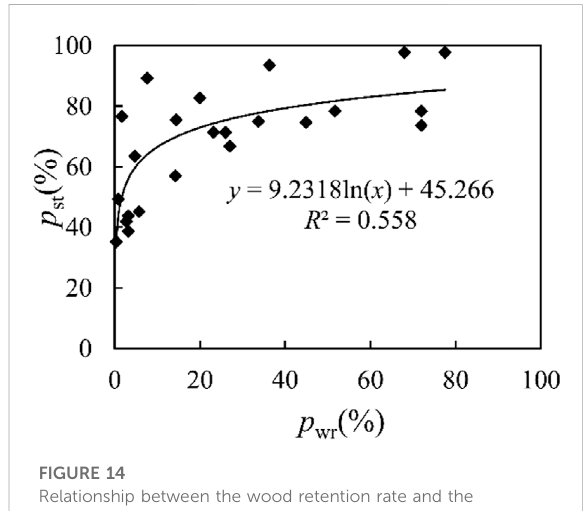
FIGURE 14 Relationship between the wood retention rate and the sediment trapping